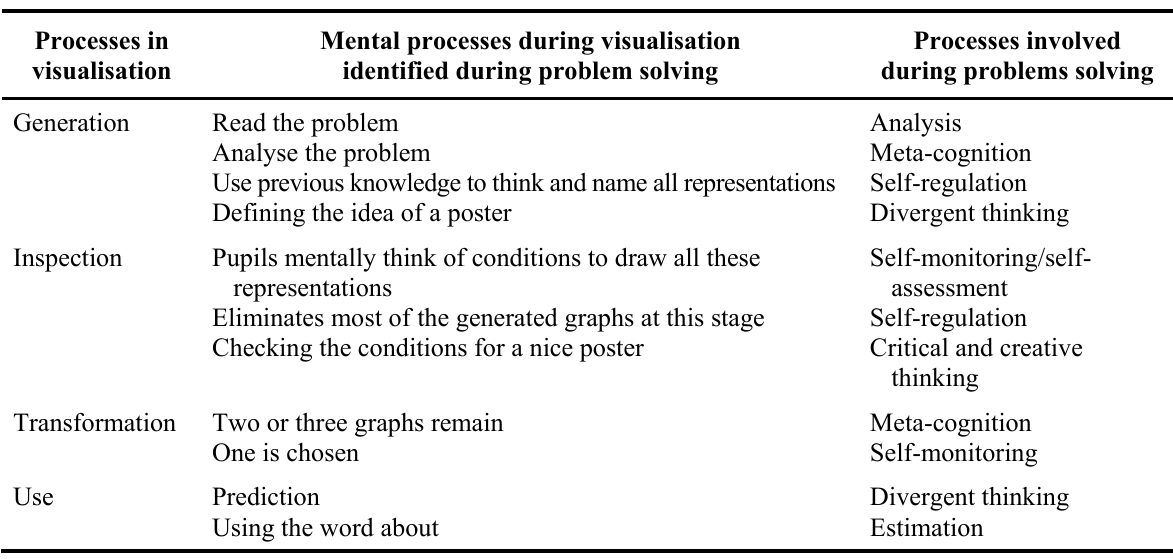
Table 3 : Results of Task